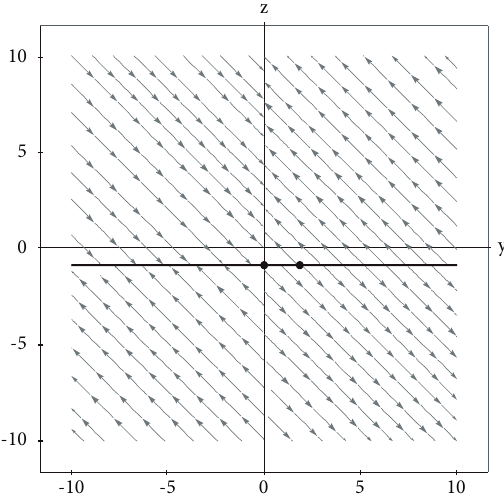
Figure 8: Phase plane of system (9), for the case where R � ρ ≃ 0 . 585 ( β ′ � 0 . 1 ) ; the other rates are δ � 0 . 071, α � 0 . 1, and σ � 0 . 17. The 0 1 vector field and some trajectories are indicated by lines and arrows in gray. In this case, the first vertical nullcline (15) is a line of zero slope whose intersection with the vertical axis z coincides with the first horizontal nullcline (16), that is, b � z ∗ (see black line); the horizontal and ≃ ( 0 , − 0 . 855 ) is unstable, and the endemic vertical remaining pair coincides with the z -axis. The disease-free equilibrium point E 0 E ∗ ≃ ( 1 . 855 , − 0 . 855 ) is a singly degenerate equilibrium; both points are indicated by a black circle.